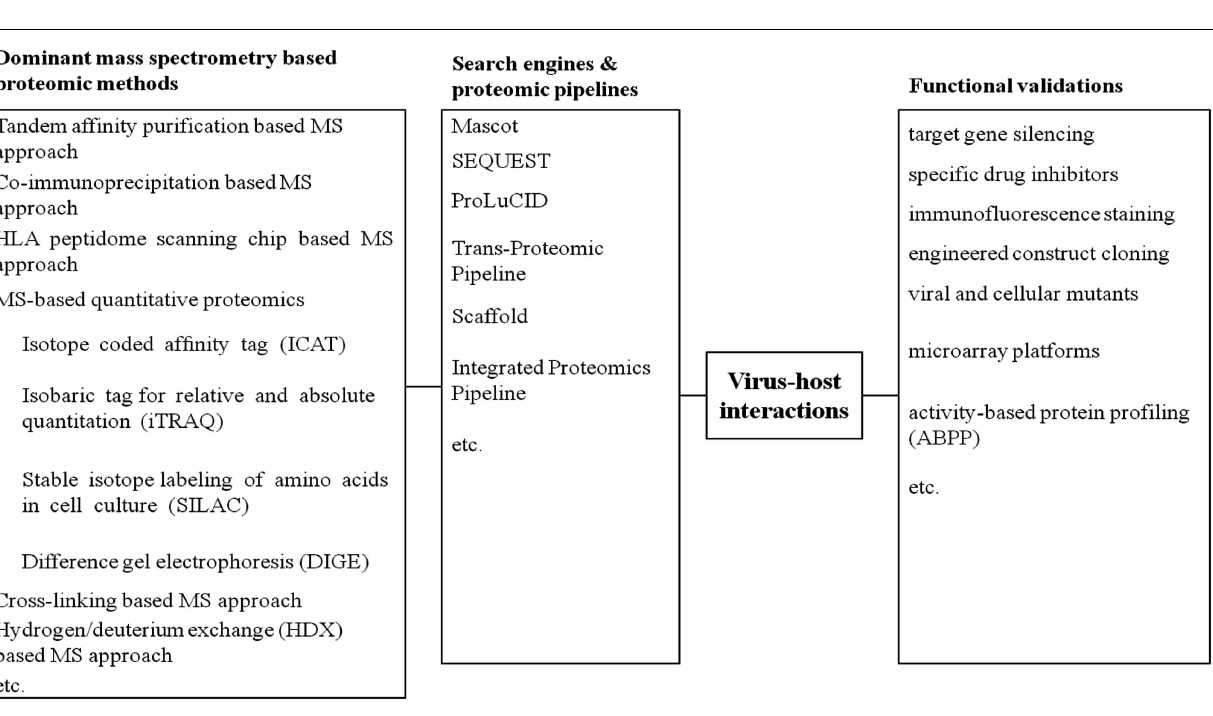
FIGURE 1 |A summary of current approaches on virus-host